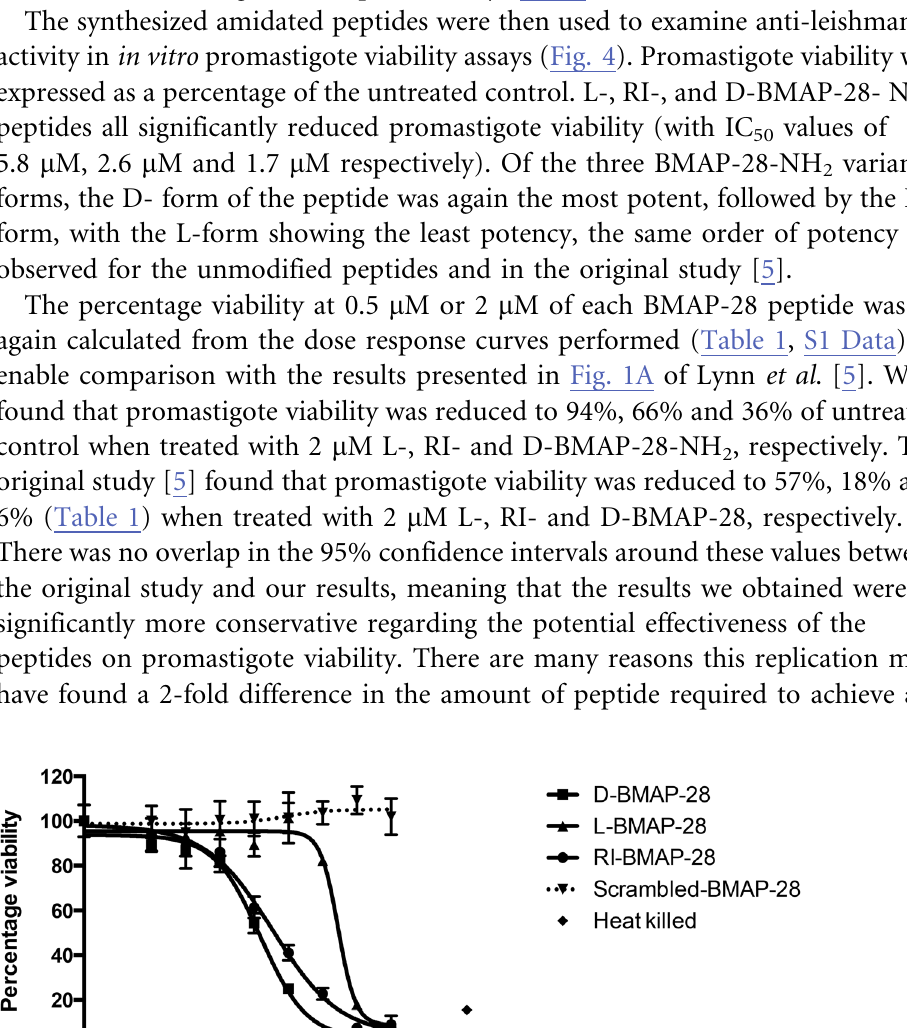
Fig. 1. HPLC profile and mass spectrum of synthesized unmodified BMAP-28 peptides. The peptides (Sequence: GGLRSLGRKILRAWKKYGPIIVPIIRIG; M.W: 3131.92; Formula: C147H252N44O31) were isolated and purified by high-performance liquid chromatography (HPLC) to greater than 95% purity. The purity and molecular weight of the respective peptides were confirmed by matrix-assisted laser desorption ionization (MALDI)-time of flight mass spectrometry. Left panels: HPLC profile, right panels: mass spectrum. A) L-BMAP-28, purity 95.61%; B) D-BMAP-28, purity 96.67%; C) RI-BMAP-28, purity 95.62%; D) Scrambled-BMAP-28, purity 95.34%.